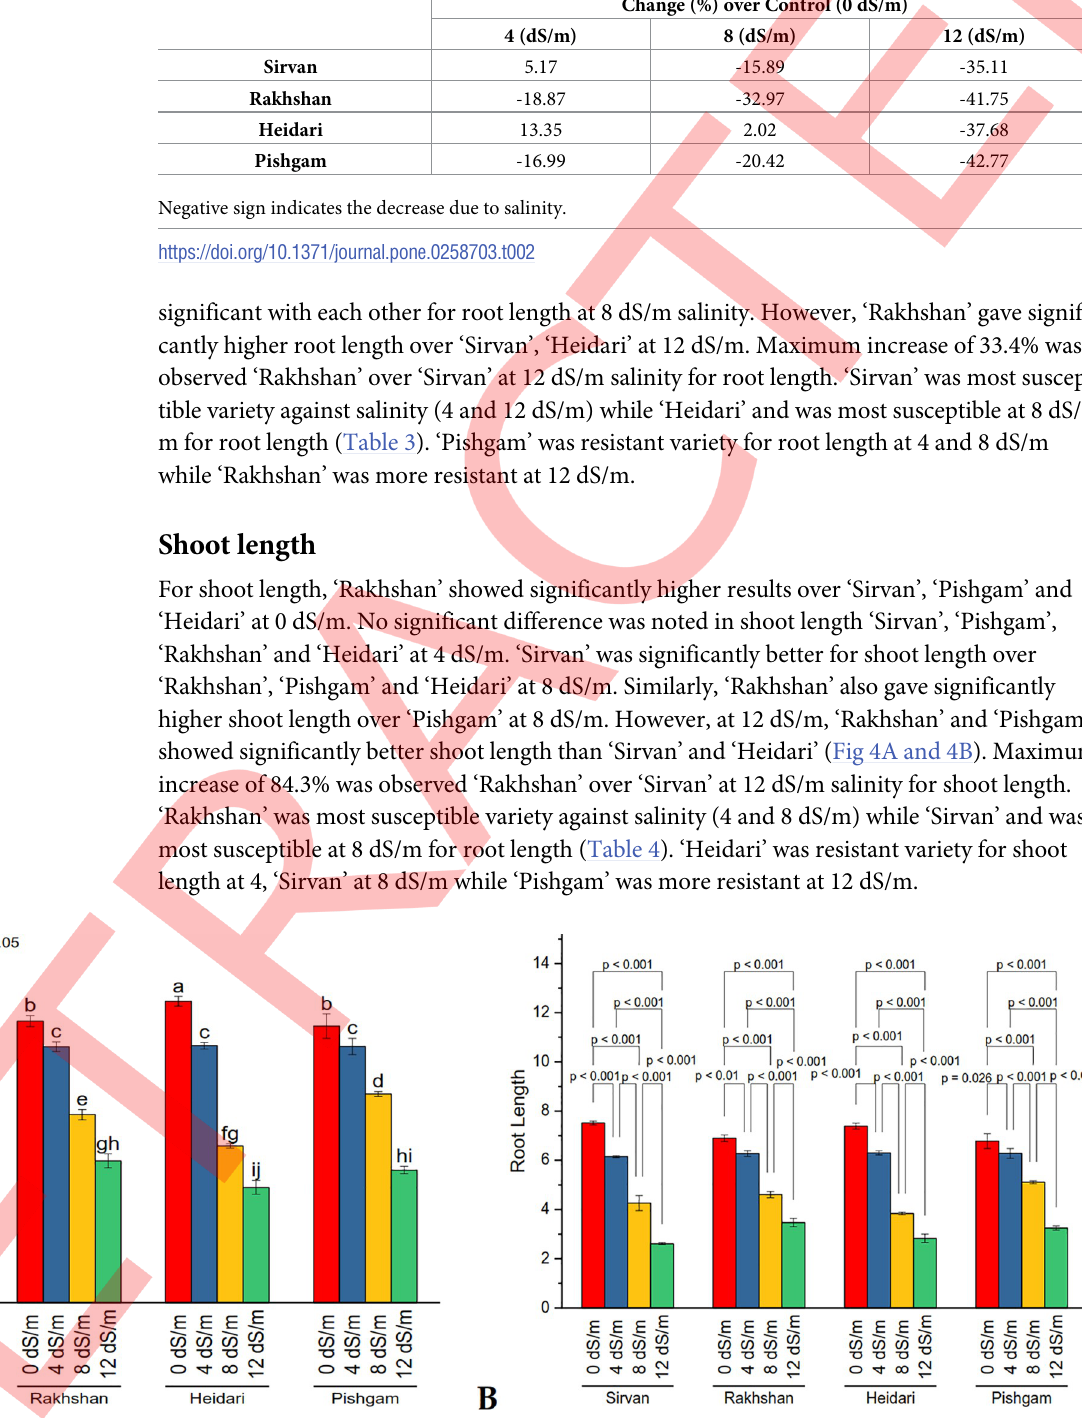
Fig 3. Effects of salinity on root length in wheat varieties. A) Means are average of four replicates. Different values showed significant difference at p < 0.05 compared by LSD. B) Different values at bars are p values obtained during LSD comparison of wheat varieties and salinity levels.